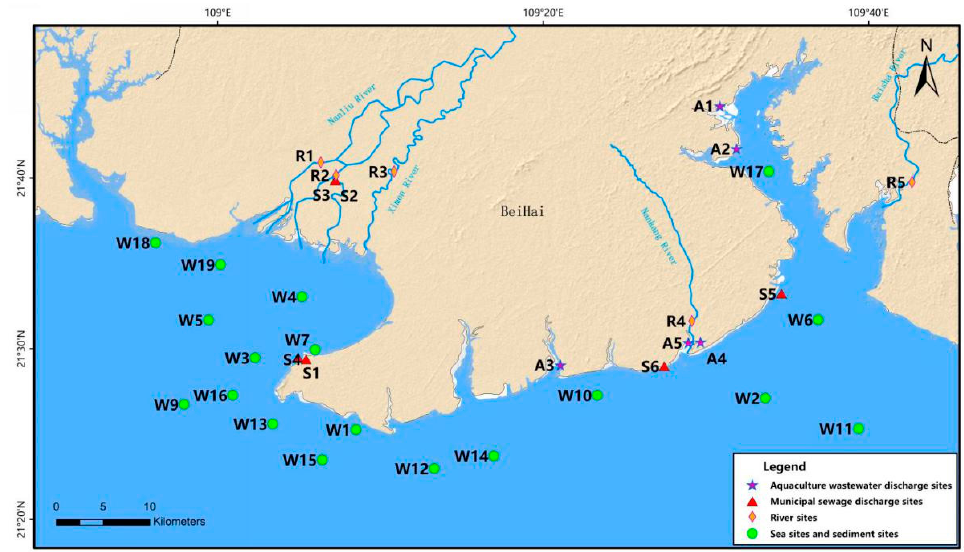
Figure 1. Map of water and sediment sampling stations in Beihai Bay, Guangxi.